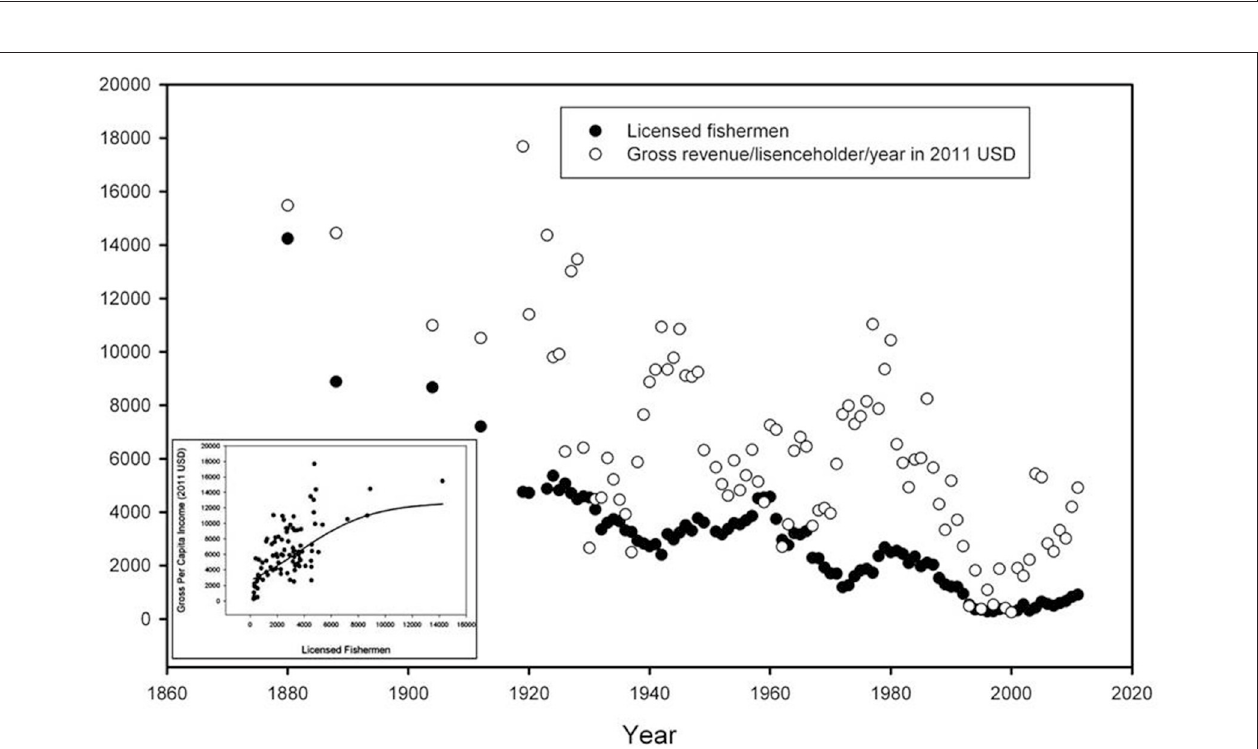
FIGURE 8 | Number of fishers and gross income over time. Embedded graph is a sigmoid fit of the data, y = 12723.3/(1 + e -((x–3623.0)/2717.7), r 2 = 0.43.